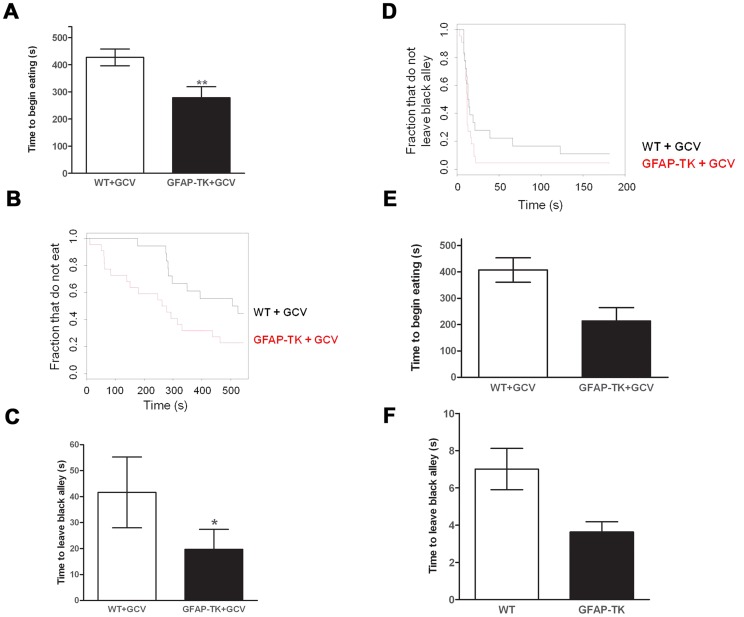
Ablating adult neurogenesis decreases anxiety.
A Time to begin eating a novel food in a novel environment, expressed as the mean latency (± s.e.m). B Time to begin eating as a survival plot (black line = wild type, n = 18, Red line = GFAP-TK, n = 22). C Time to emerge from a black alley and enter a white alley expressed as the mean latency (± s.e.m). D Time to emerge from a black alley survival plot (black line = wild type, n = 18, Red line = GFAP-TK, n = 22). Grey vertical line at right side of survival plots represents the termination of the experiment. *p<0.05, **p<0.01 significantly different from GCV-treated wild type controls. E Time to begin eating a novel food and F Time to emerge from a black alley in untreated WT (n = 26) and GFAP-TK (n = 18) rats.